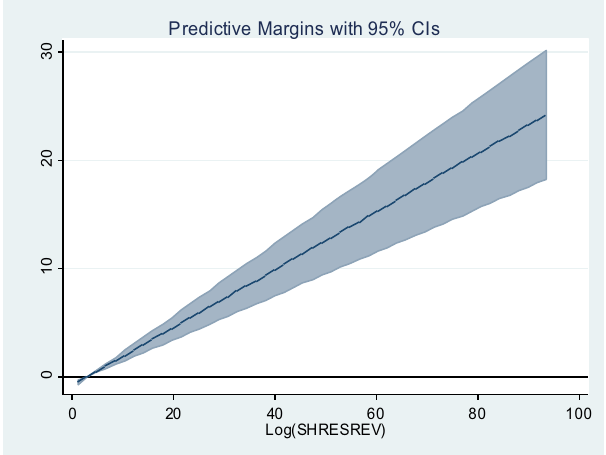
Figure 2. Marginal impact of “ RESREVVOL ” on “ NRESREVVOL ” , for varying levels of “ SHRESREV